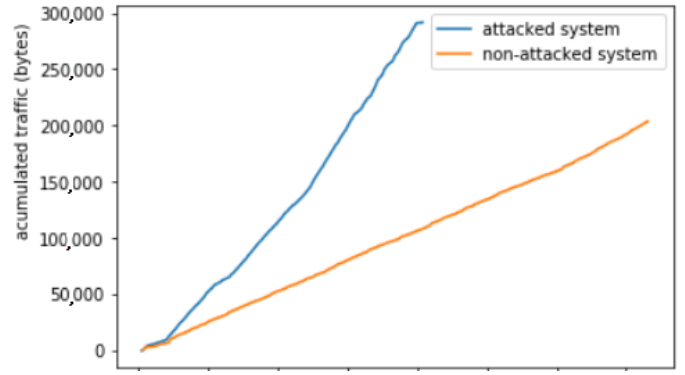
Figure 21. Accumulated traffic with topic